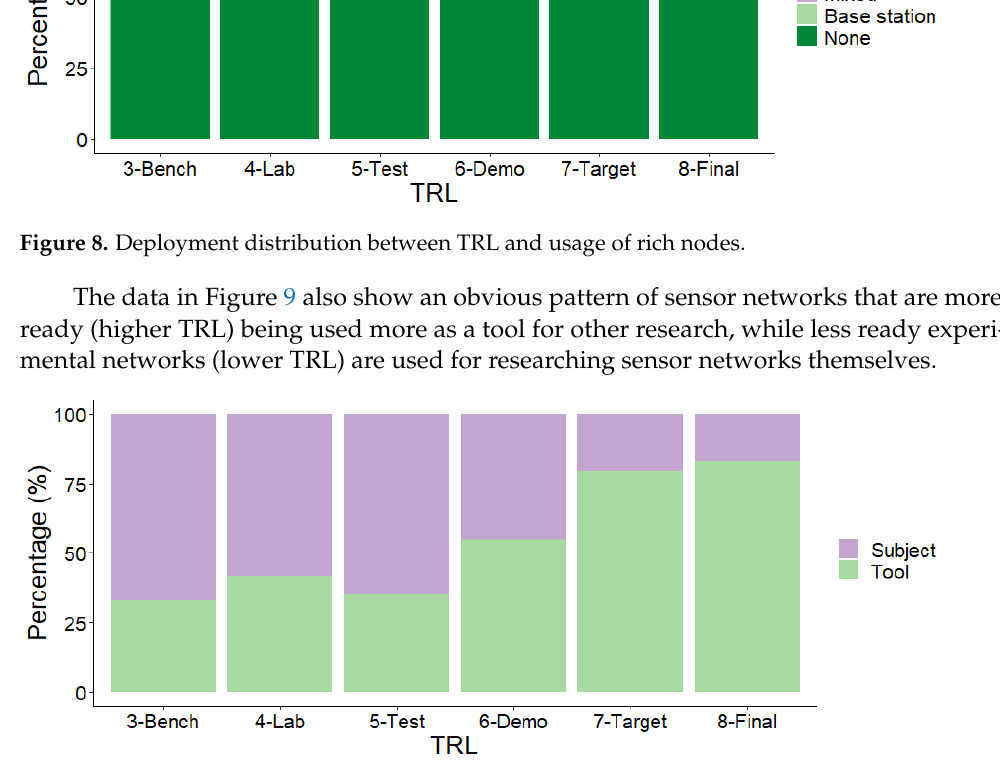
Figure 9. Deployment distribution between TRL and deployment